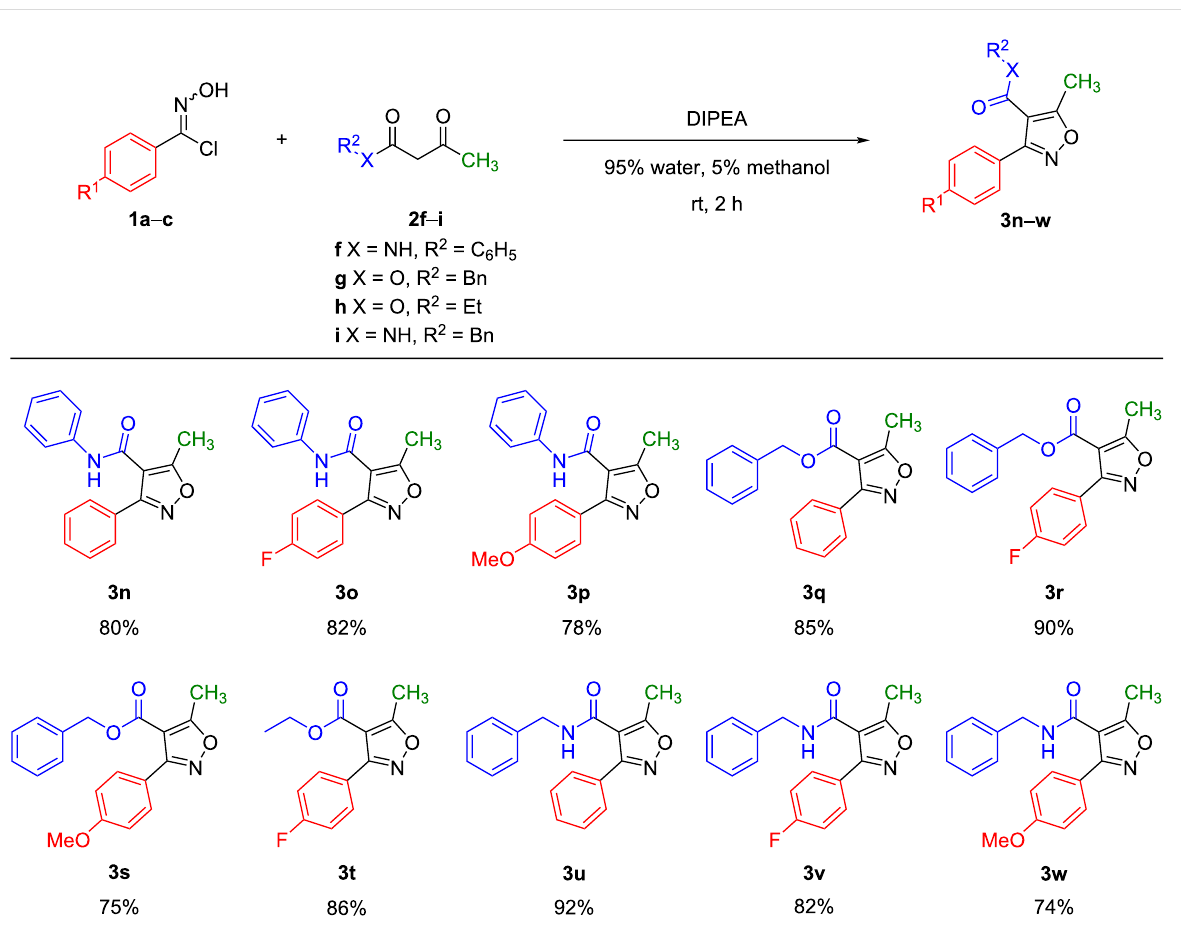
Figure 4: Reactions between various phenyl hydroximoyl chlorides and β -ketoesters or β -ketoamides. The reactions were performed with 0.5 mmol of 1 , 0.5 mmol of 2 , and 3 equivalents of DIPEA in 15 mL of 95% water, 5% methanol at room temperature for 2 hours. The yields were calculated after the isolation and purification of products.